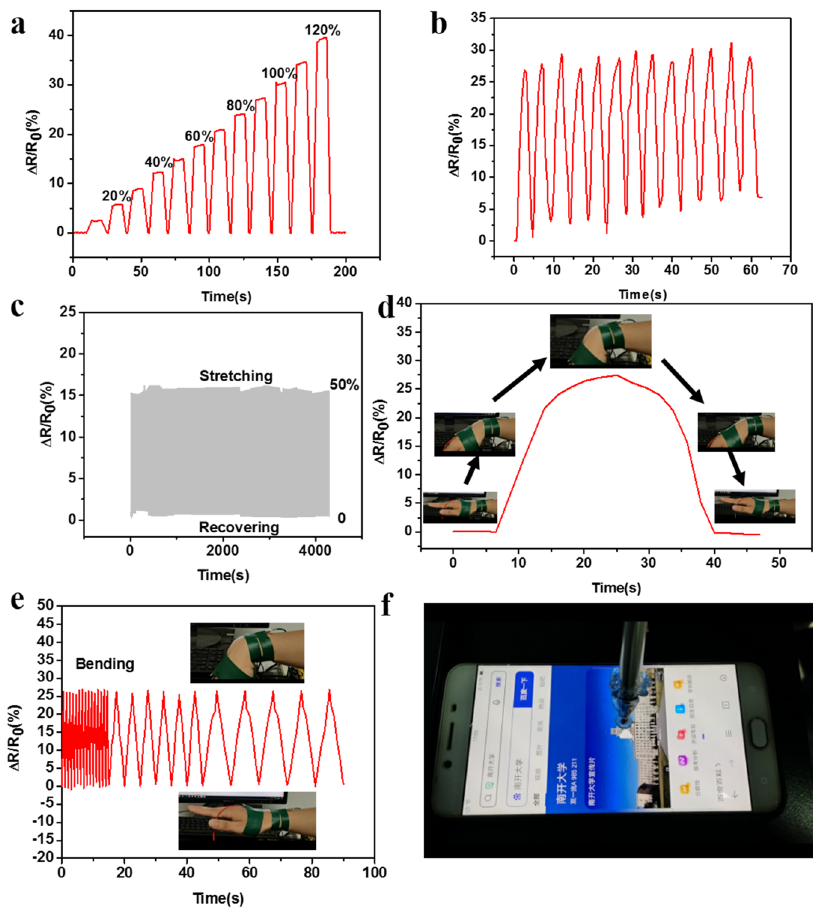
Fig. 8 The sensing performance of hydrogels and the control of electronic screen. a Δ R/R 0 curves of the hydrogel under different tensile strains (ACA- PEG 20000 -ACA: Hy- α -CD = 1:5). b Δ R/R 0 curves of the hydrogel during the stretching-recovery cycle when the tensile strain is 90%. c The Δ R/R 0 curve of the hydrogel under 300 cycles of load-unload. d Real-time signal of the wrist movement. e At different bending speeds. f Image of the phone controlled by the conductive